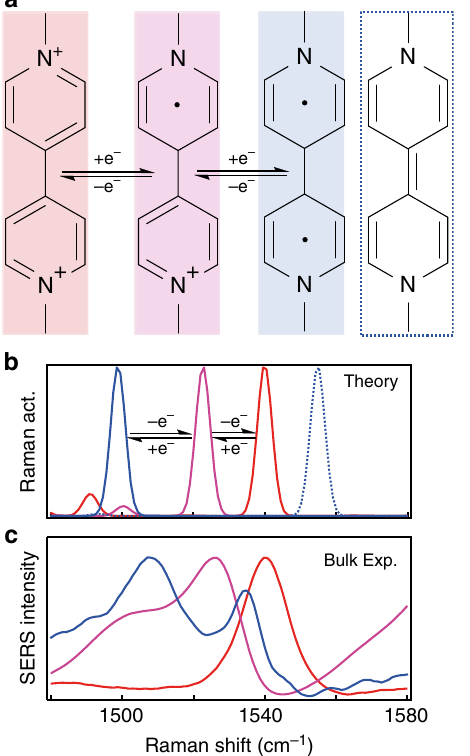
Fig. 3 Redox behaviour of molecular tunnelling junction VI (methyl-viologen). a Chemical structures of different redox states of VI . b DFT-calculated Raman spectra and c experimental Raman from bulk solutions in which VI 2+ ( red ) is chemically reduced to VI 1+ ( purple ) using dithionite, and VI 0 (triplet, blue ) using NaBH 4 or Na 2 S 2 O 4 in the presence of Au nanoparticles (see Supplementary Fig. 10). The singlet VI 0 state ( blue dotted line ) is intermittently observed in NPoM